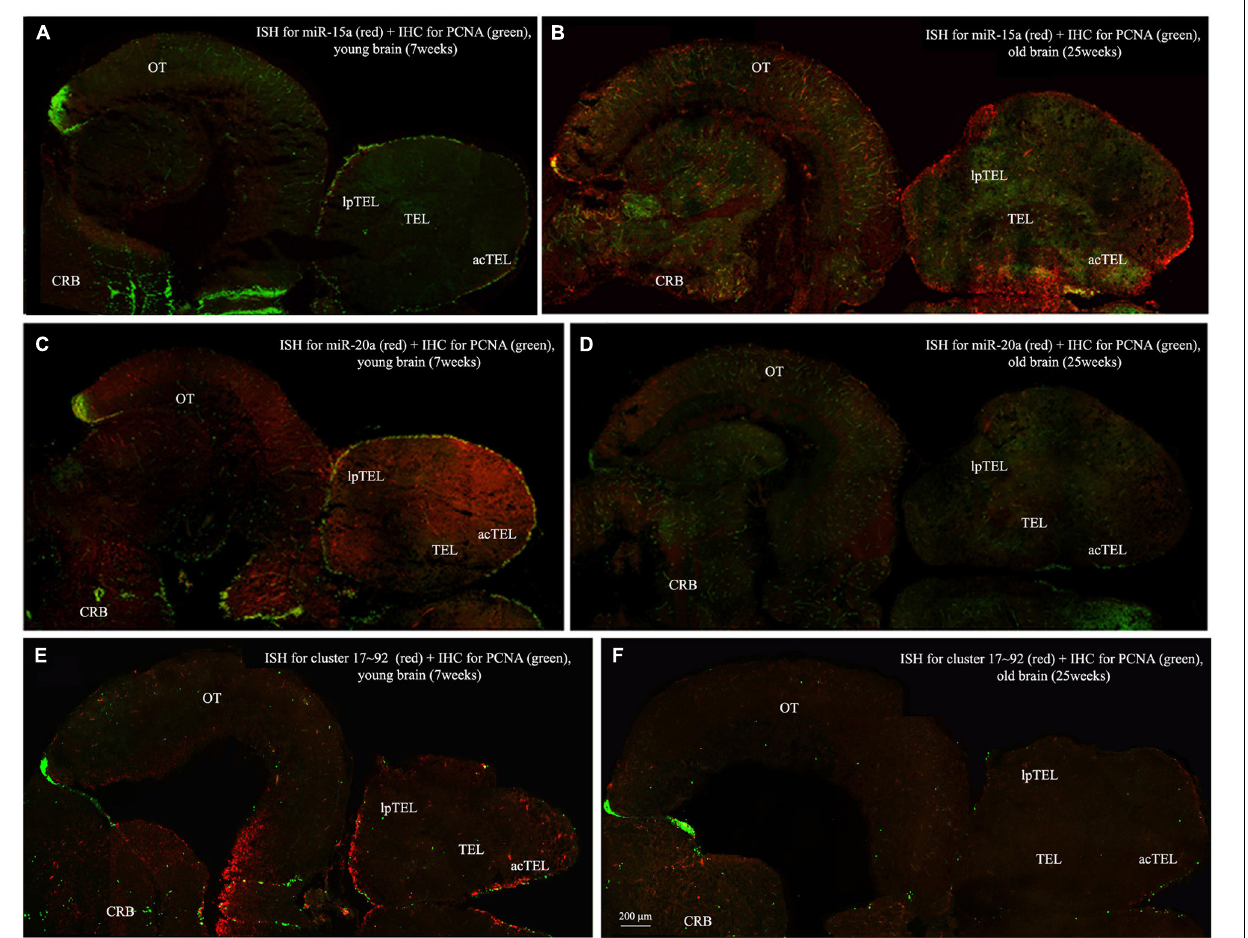
FIGURE 3 | Overviews of Nothobranchius furzeri hemi-brain. In situ Hybridization (ISH, in red) for miR15 (A,B) , miR20 (C,D) and Cluster17–92 (E,F) , double stained with PCNA (in green) by immunohistochemistry (IHC), in